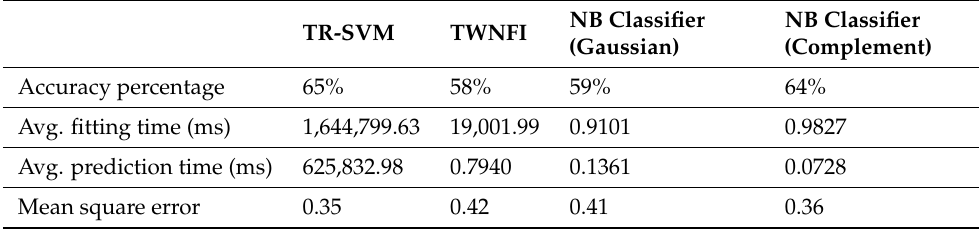
Table 15. Results of different models with experimental unit conversion